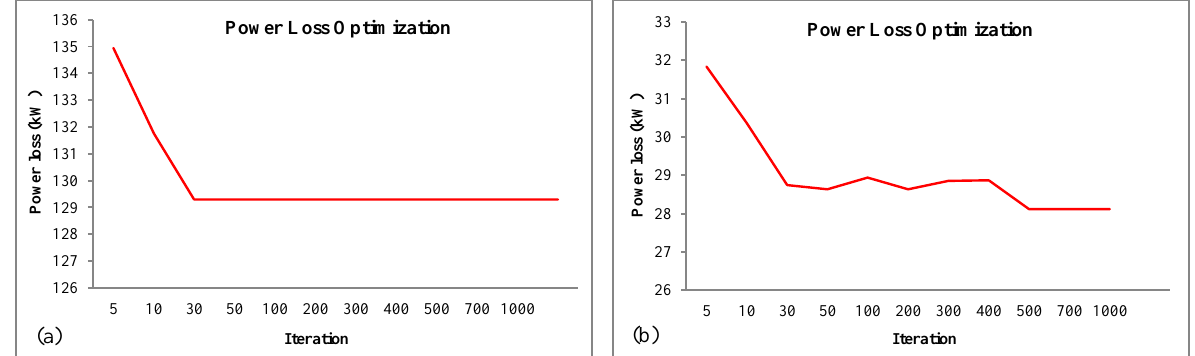
Figure 5. Power loss change to iteration during optimization of IEEE model distribution network 33-bus with three SGs; (a) original network optimized, and (b) SG installed network optimized.